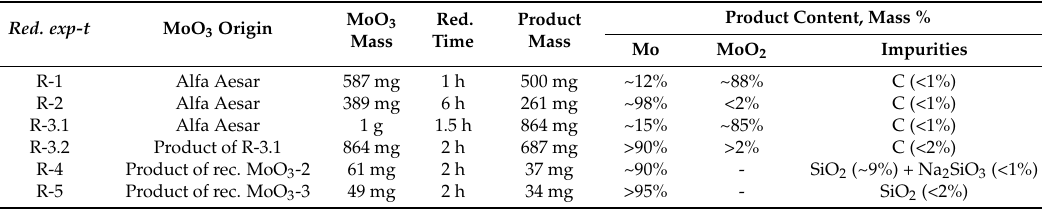
Figure 5. The optimized MoO 3 reduction thermal cycle. Table 2. MoO 3 reduction experiments.